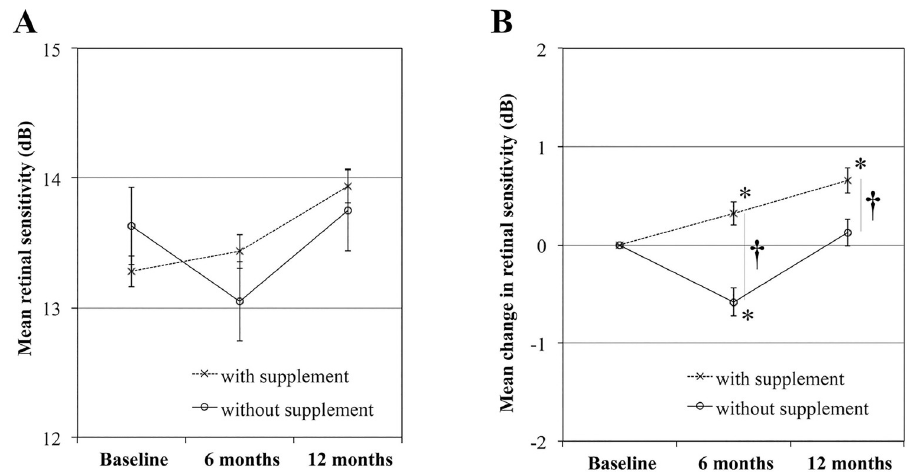
Fig 5. The impact of supplementation on the mean retinal sensitivity. (A) The temporal changes in the mean retinal sensitivity in groups with and without supplementation. (B) The changes in the mean retinal sensitivity from baseline. (†P < 0.01, ANOVA; � P < 0.01 compared with baseline, paired t-test).